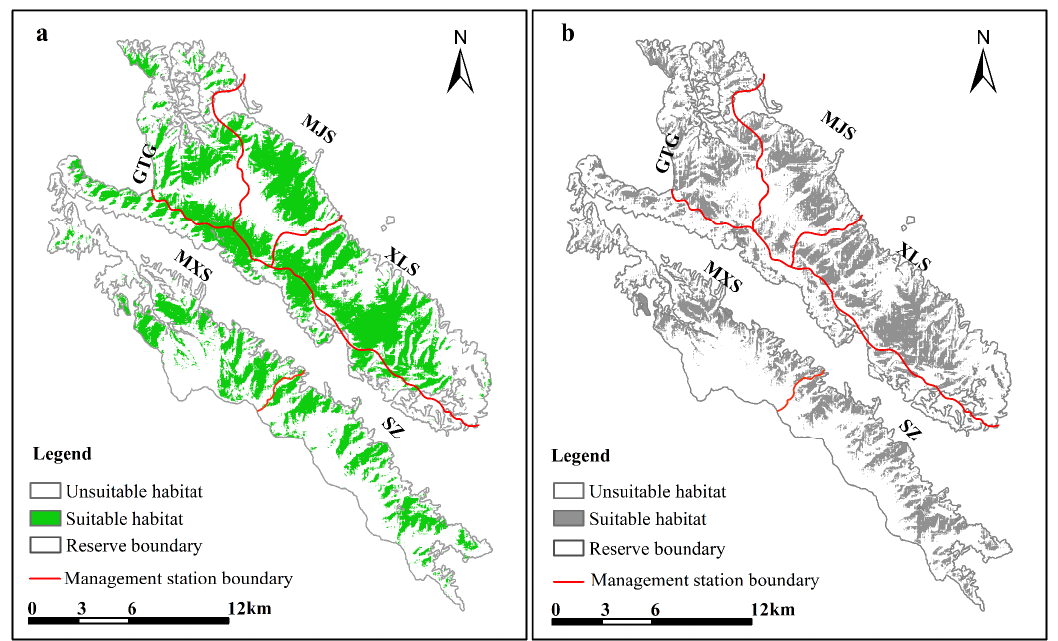
Figure 5. Current climatically suitable area for AMD during two periods as determined by the model: ( a ) green grass period and ( b ) withered grass period.